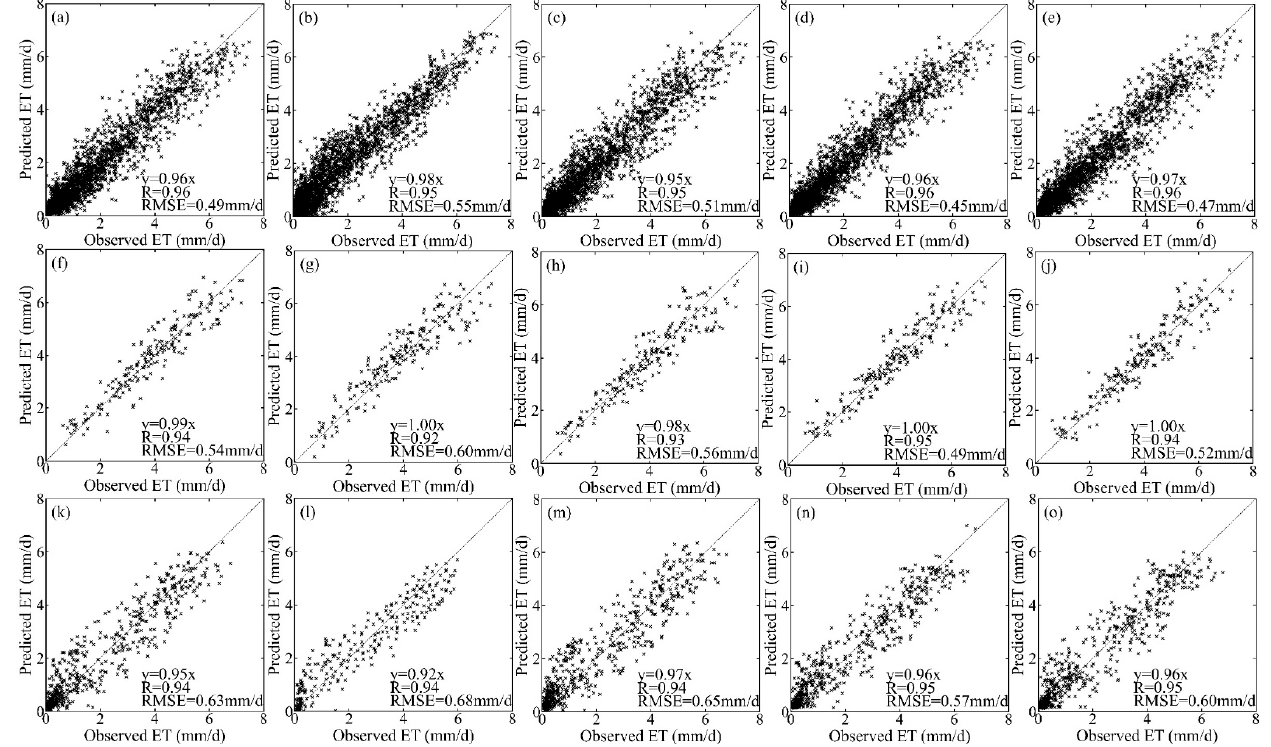
Figure 6. Ten-fold cross-validation results of methods (from left to right are ANN, BLR, DBN, GPR, and RF) over the homogeneous underlying surface ( a – e ), the moderately heterogeneous underlying surface ( f – j ), and the highly heterogeneous underlying surface ( k – o ) at three superstations.